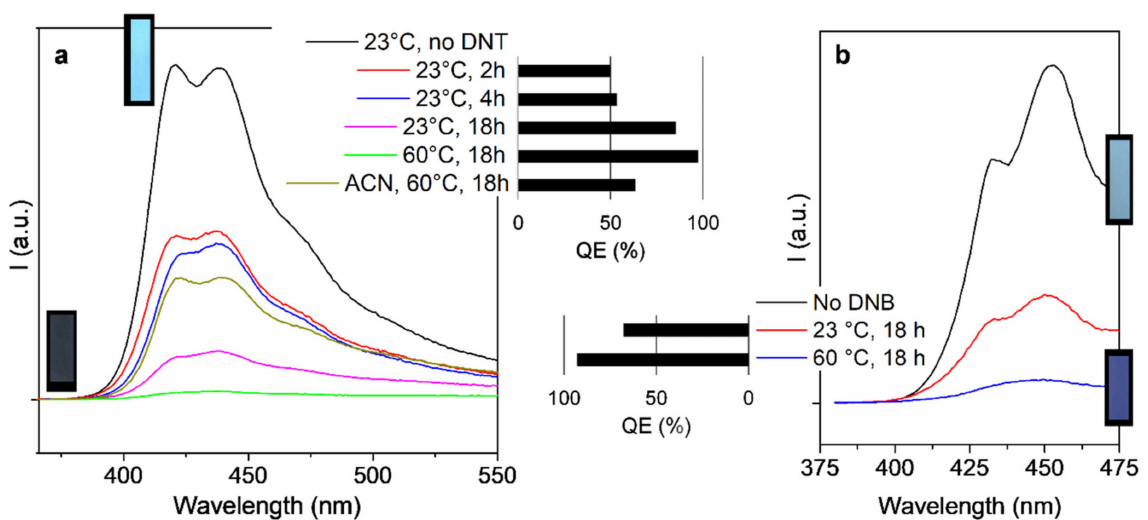
Figure 4. Fluorescence quenching of paper strips coated with HTMA-PFP ( a ) and PEDMA-DO-PBF ( b ), with DNT and o -DNB, respectively. The quenching efficiency is represented as a 0–100% bar in each case. Pictures for the extreme cases (no nitroaromatics and maximum QE ) under UVA radiation are provided.